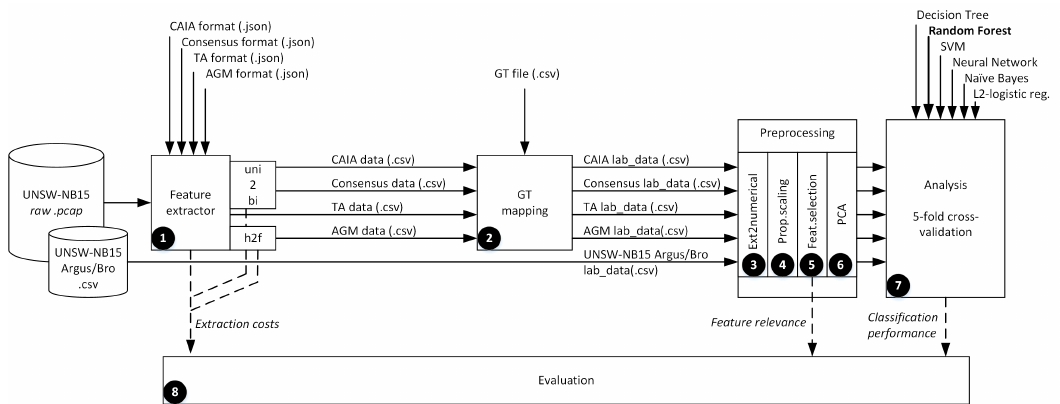
Figure 2. Scheme of the conducted